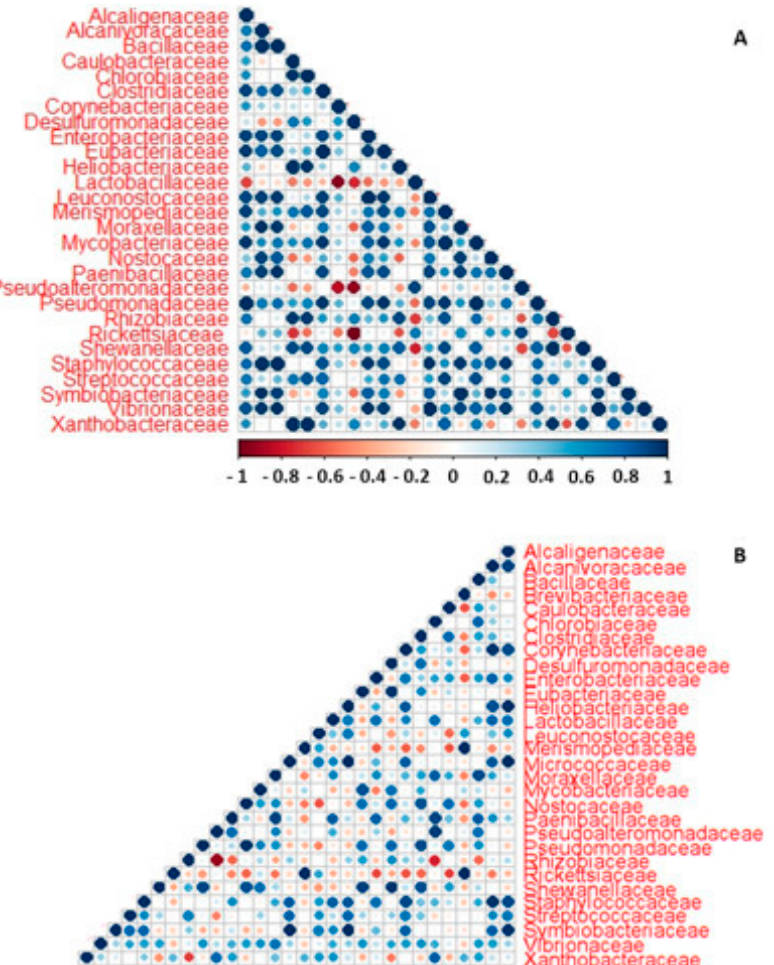
Figure 6. Correlogram analysis. The correlations computed among the members of the microbial communities harbored in the rind and core of the cheese wheel are depicted in panels ( A , B ),